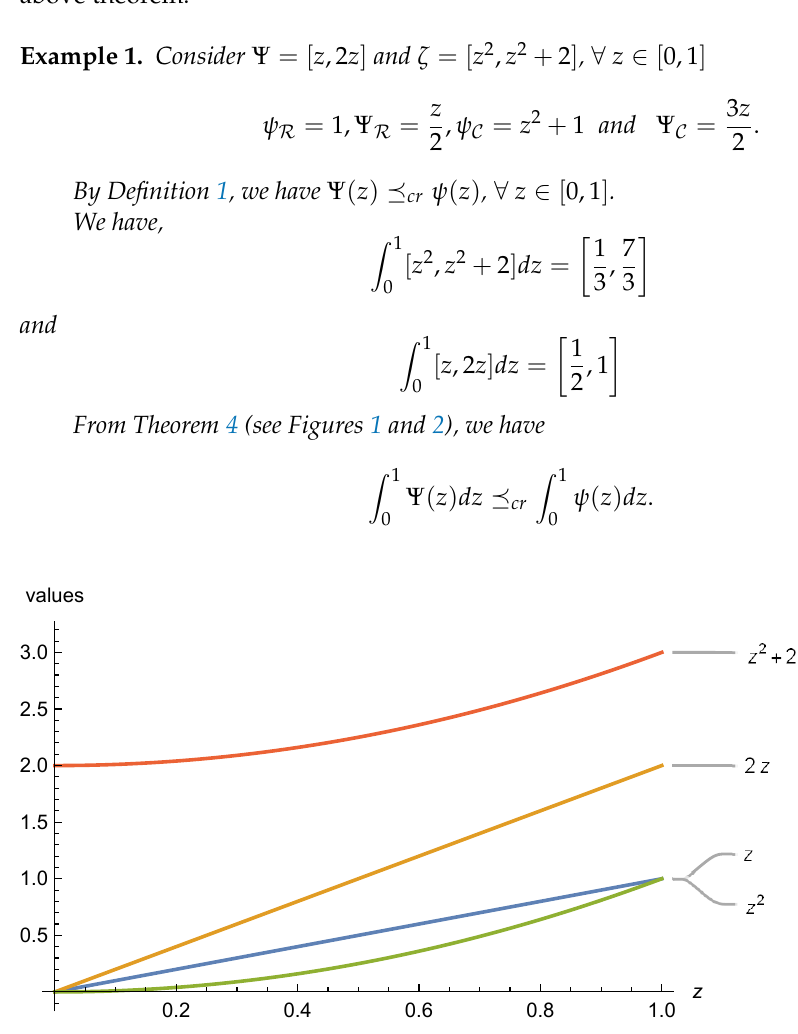
Figure 1. As you can see from the graph, the cr-order relation holds.